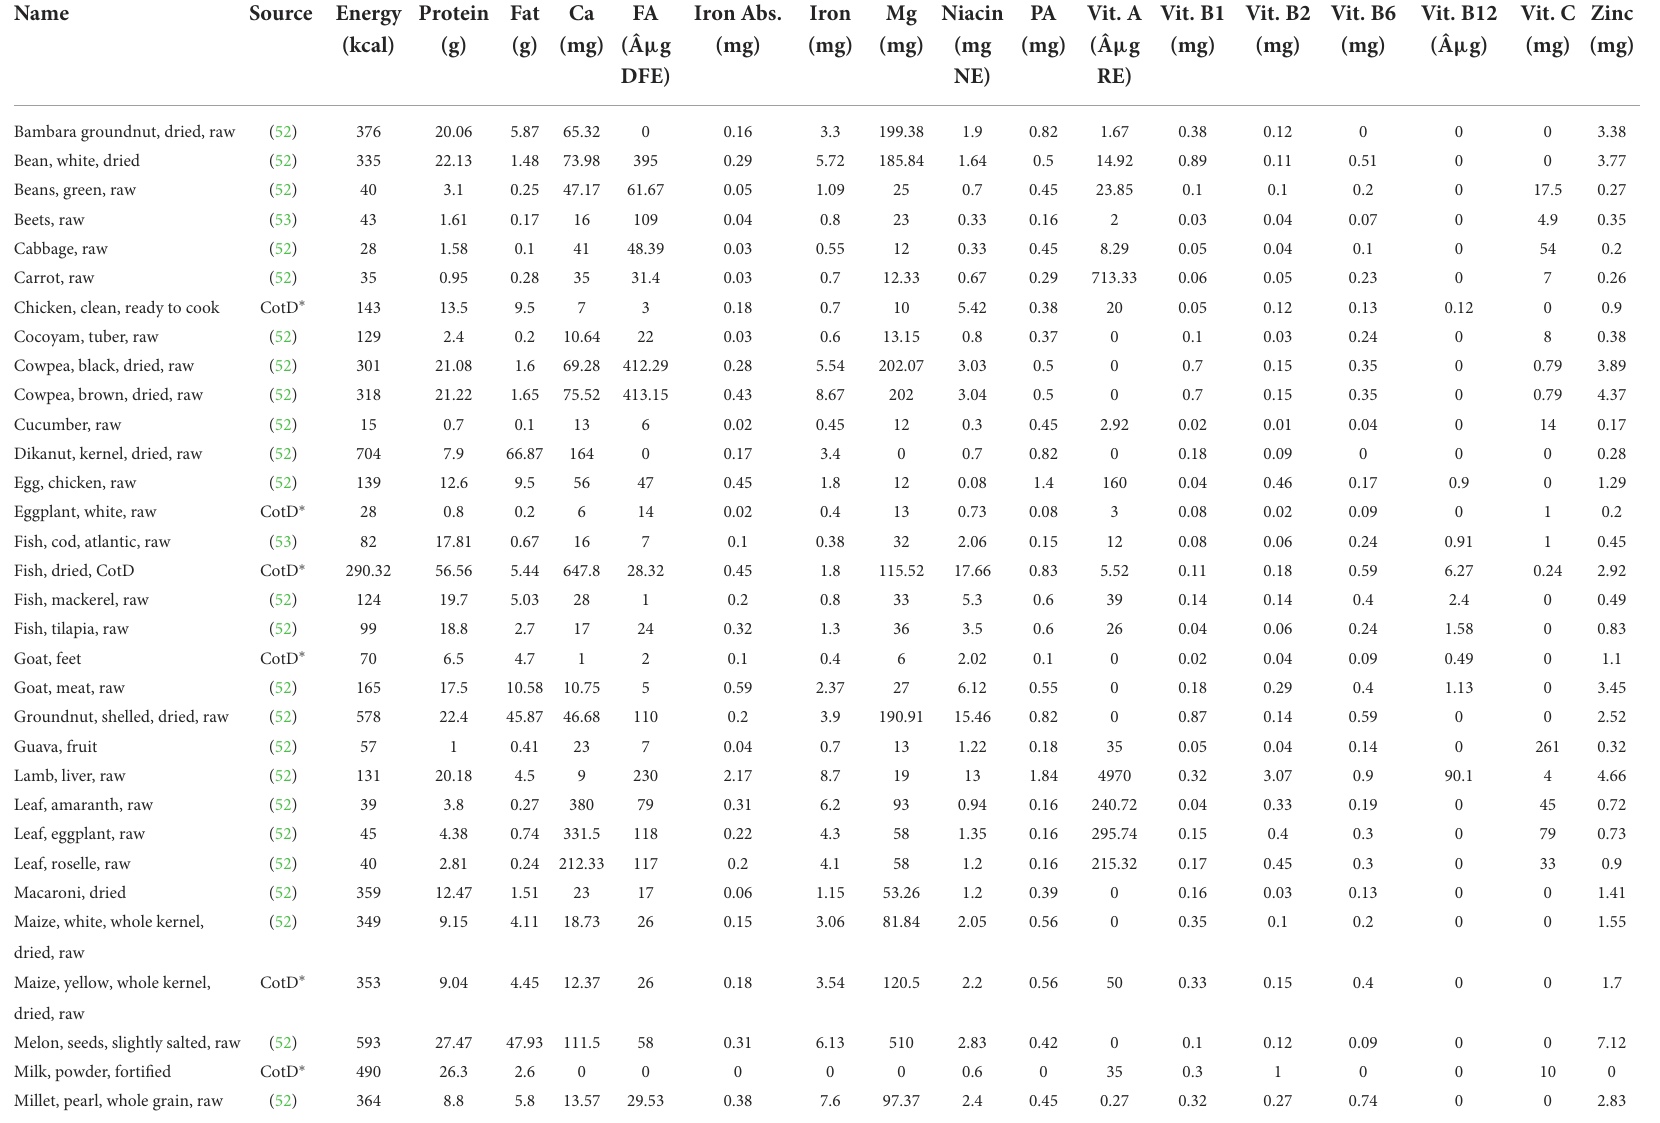
TABLE 2 Nutritional properties reported per 100 g of food commodities available in